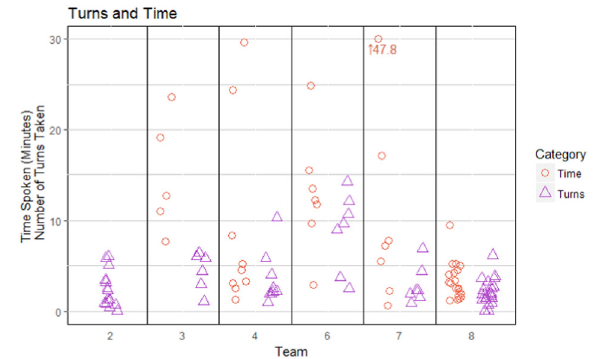
Fig. 2 Time spoken and number of turns-taken in 10-min.